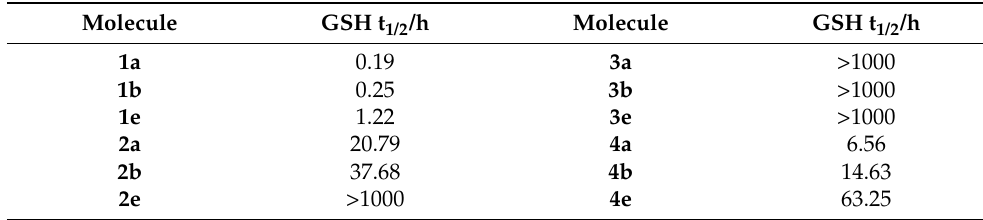
Table 1. GSH results for selected molecules in the benchmark